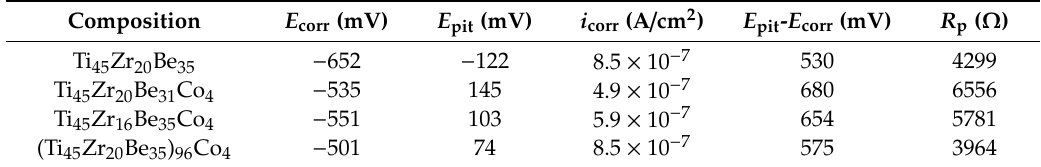
Table 8. The variation of corrosion potentials, pitting potentials, passive region widths, corrosion current densities, and polarization resistances of Ti 45 Zr 20 Be 35 , Ti 45 Zr 20 Be 31 Co 4 , Ti 45 Zr 16 Be 35 Co 4 , and